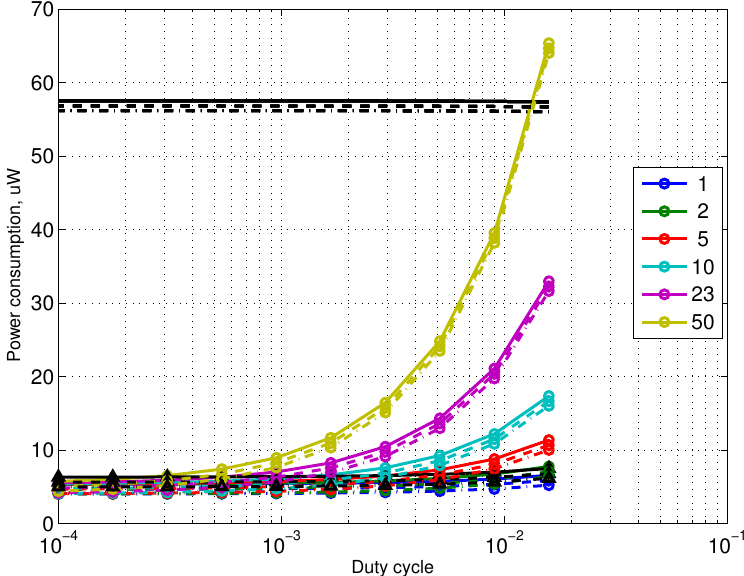
Figure 14. When M t = 1 and M r = 2, power consumption while operating with reloading the capacitor while operating with capacitor ( C s = 0.35 F). Non-WuR in black (without triangles), passive WuR in colors indicating number of nodes for different host duty cycles per node ( β (cid:48) w ). Semi-passive WuR in black with triangles. Line type indicates used SC leakage current model as —: upper , - - -: median, and -.-.-: lower.